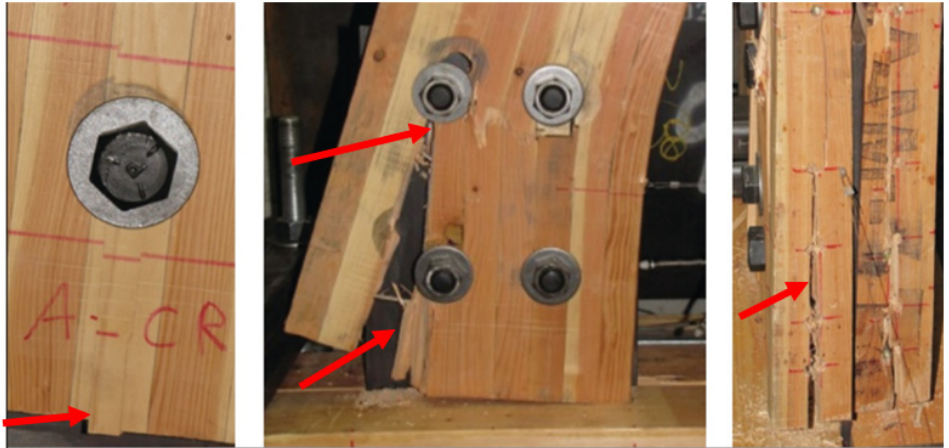
Figure 7. Typical failure for reinforced slotted-in plate connection under cyclic loads, plug shear, splitting, and wood embedment failures, respectively, (adapted from [30]).